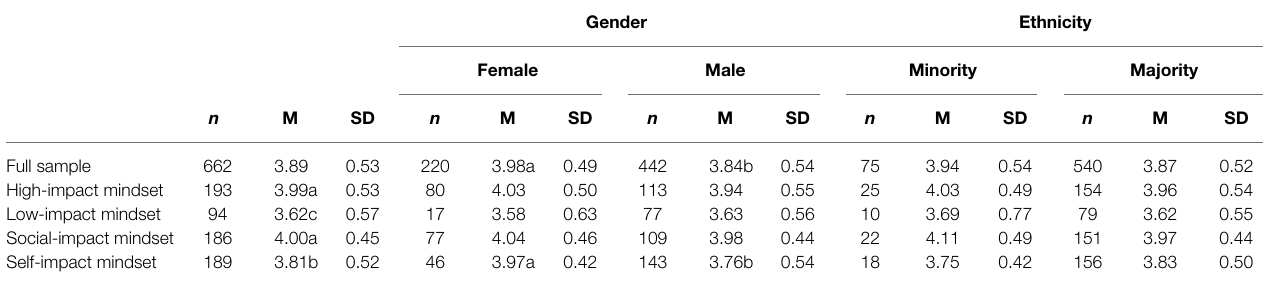
TABLE 3 | Mean-level analysis sense of purpose.